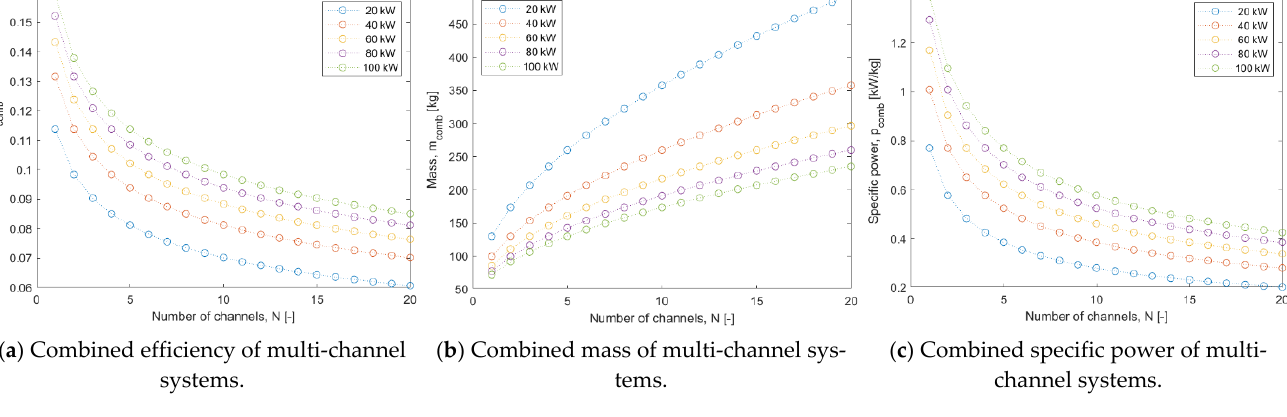
Figure 11. System parameters of N-branch system with non-constant component parameters.